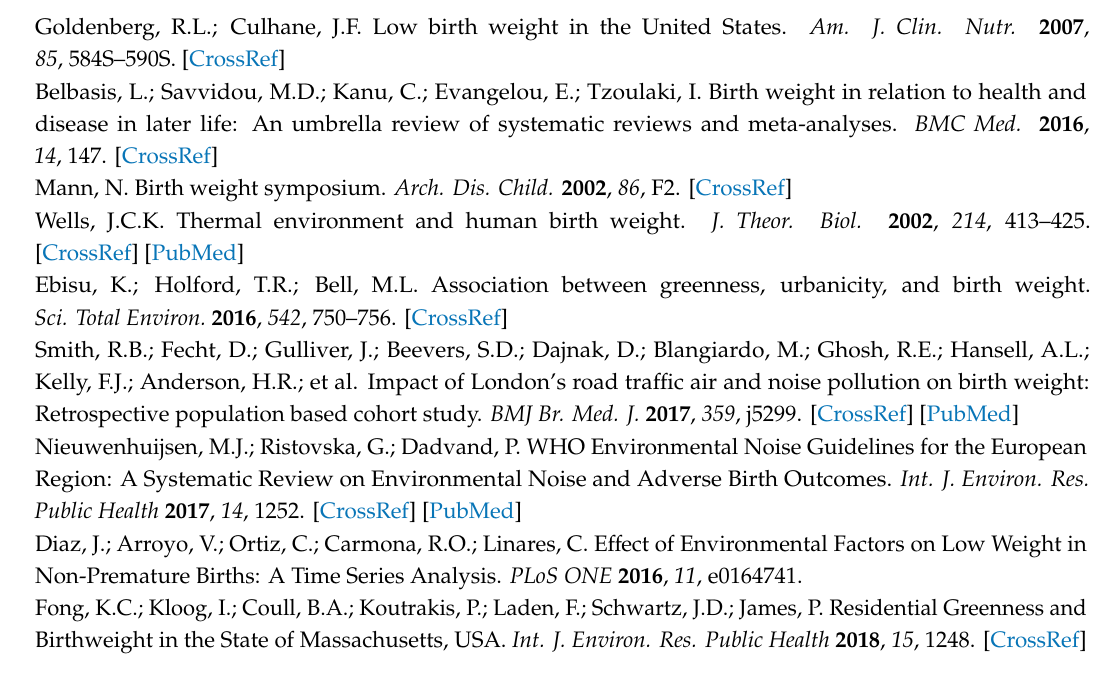
Table S1: Maternal and neonatal characteristics of women who were excluded from the analysis. Table S2: Census area economic segregation and dissimilarity indices. Table S3: A multi-exposure model for the association between birthweight and each environmental exposure, built environment characteristic and economic indices during pregnancy. Table S4: Sensitivity analyses: the association between birthweight and each environmental exposure, built environment characteristic, and economic indexes during pregnancy in a multi-exposure model. Figure S1: The associations between the exposures and birthweight using penalized splines to allow for nonlinear associations: results of a multivariate regression. Figure S2: The mean PM 2.5 exposure during pregnancy per census block group, among women who gave birth in Massachusetts between 2001 and 2011. Figure S3: The mean temperature exposure during pregnancy per census block group, among women who gave birth in Massachusetts between 2001 and 2011. Figure S4: The mean greenness exposure during pregnancy per census block group, among women who gave birth in Massachusetts between 2001 and 2011. Figure S5: The mean noise exposure during pregnancy per census block group, among women who gave birth in Massachusetts between 2001 and 2011. Figure S6: The mean walkability index during pregnancy per census block group, among women who gave birth in Massachusetts between 2001 and 2011. Figure S7: The mean economic residential segregation (ERS) exposure during pregnancy per census block group, among women who gave birth in Massachusetts between 2001 and 2011. Figure S8: The mean index of economic dissimilarity (IED) exposure during pregnancy per census block group, among women who gave birth in Massachusetts between 2001 and 2011. Figure S9: The weighted contribution of each of the selected exposures to a negative di ff erence in birthweight: results of a Weighted Quantile Sum (WQS) regression with weights assigned to tertile-scored exposures. Figure S10: The weighted contribution of each of the selected exposures to a negative di ff erence in birthweight: results of a Weighted Quantile Sum (WQS) regression with weights assigned to quintile-scored